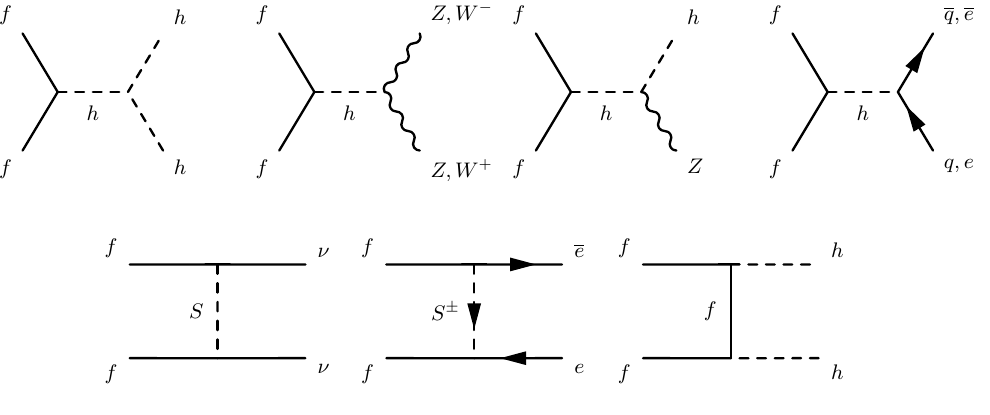
Figure 18 . Annihilation diagrams for fermionic DM.